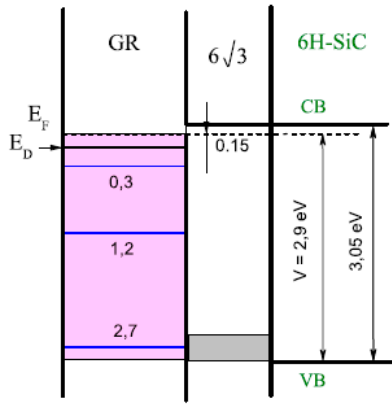
? 3 interface carbon